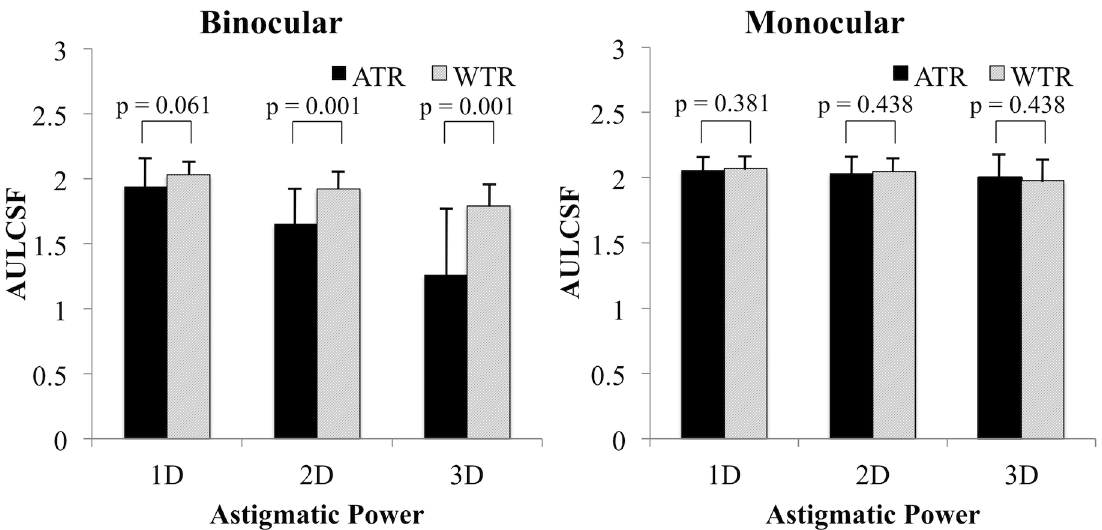
Fig 2. Comparison of area under the log contrast sensitivity function (AULCSF) between against-the-rule (ATR) and with-the-rule (WTR) astigmatism. In binocular +2.00 and +3.00 D astigmatic defocus, ATR astigmatism resulted in significantly worse AULCSF than WTR astigmatism. In monocular astigmatic defocus, AULCSF showed no significant differences between ATR and WTR astigmatism.